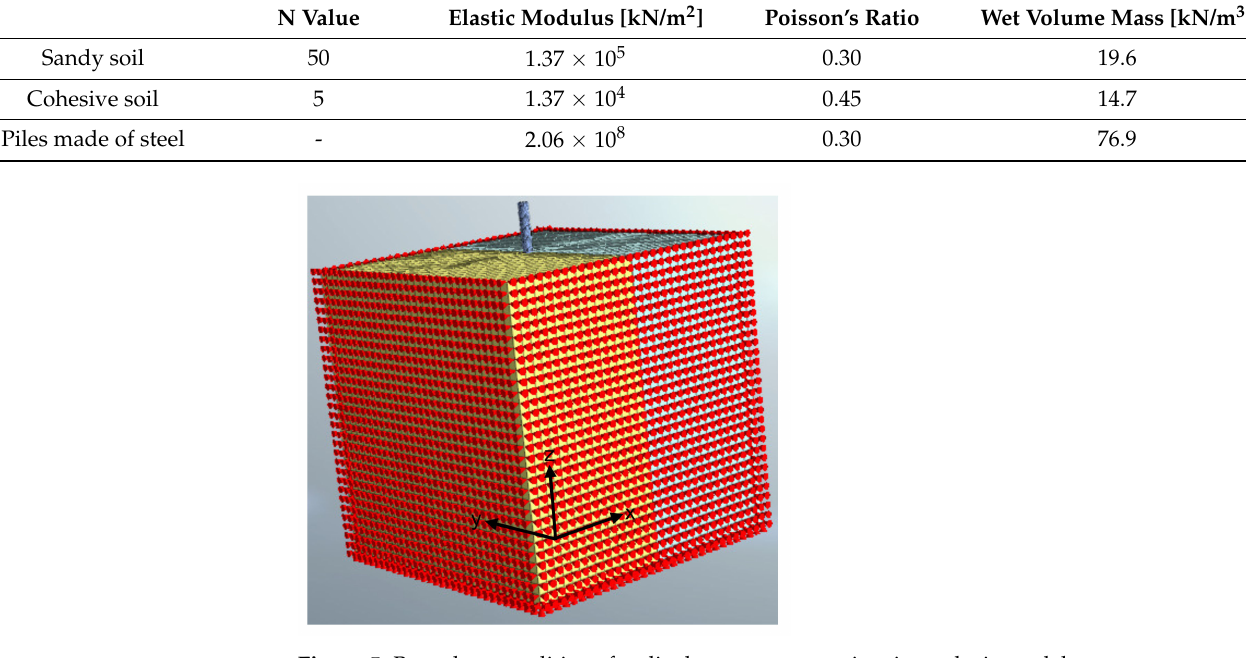
Figure 5. Boundary conditions for displacement constraints in analysis